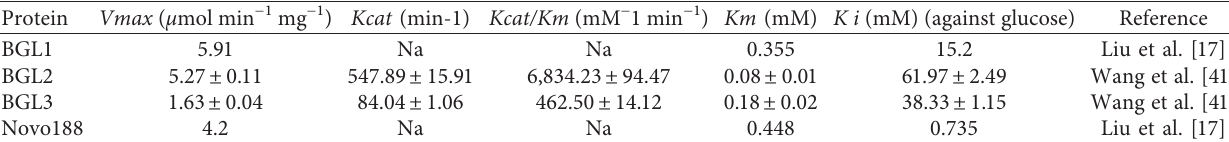
Table 3: Kinetic parameters of partially purified β -glucosidases from Clavispora NRRL Y-50464.